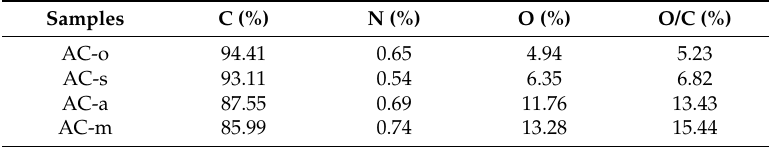
Table 3. Contents of oxygen functional groups in the studied samples obtained from Boehm titration. Carboxyl Sample (mmol/g)